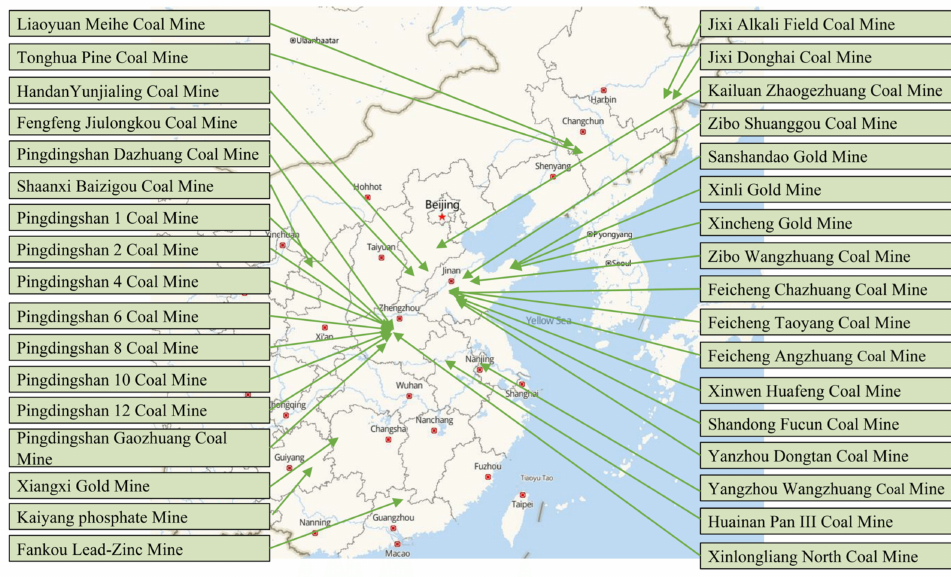
Figure 1. Locations of the selected